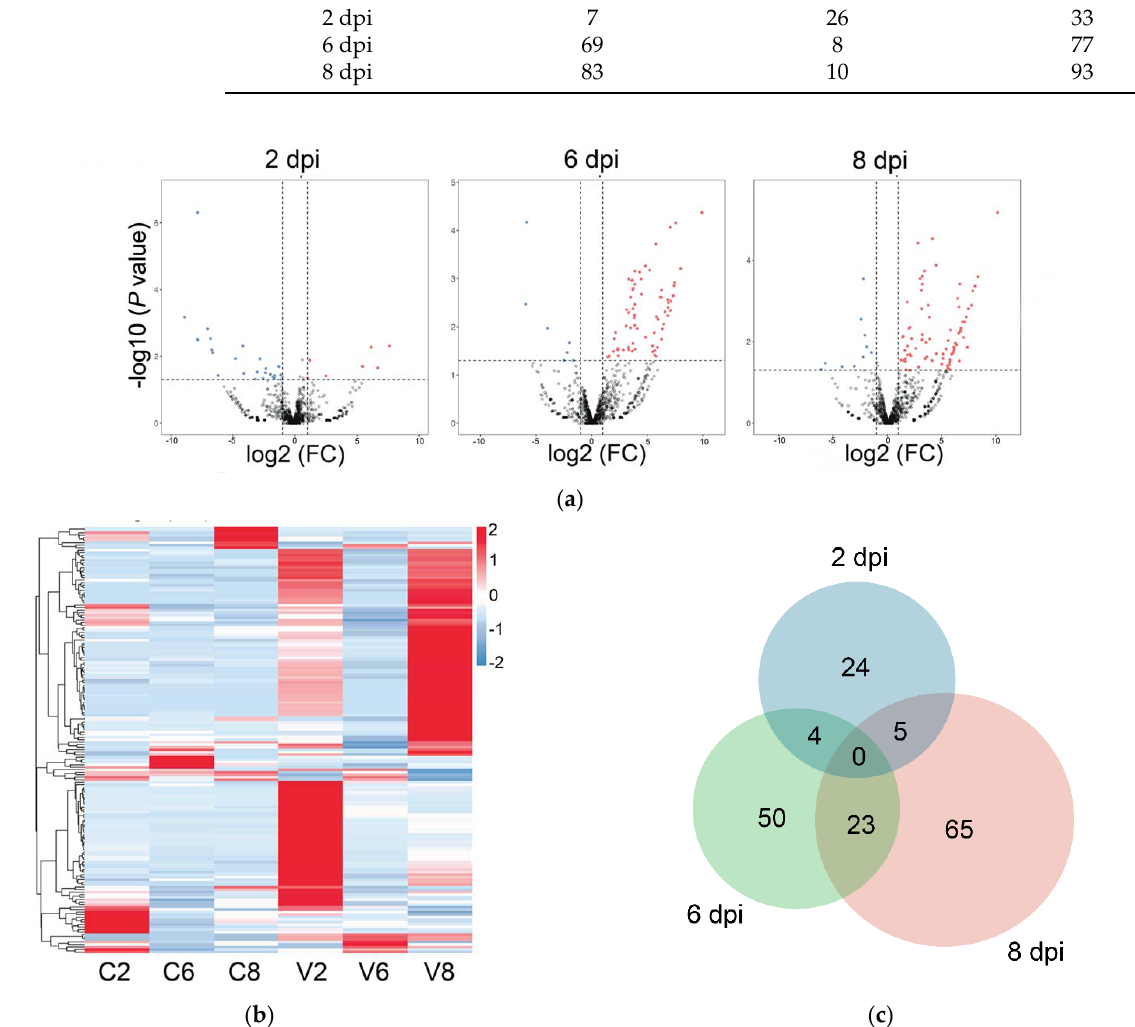
Figure 2. Analysis of differentially expressed miRNAs (DEmiRs) at different time points of infection. ( a ) Volcano plots of DEmiRs, at 2, 6, or 8 days post infection (dpi). The red and blue points represent up- and downregulated miRNAs, respectively; gray points represent miRNAs without significant change. FC, fold change; ( b ) The heatmap of DEmiR expression profiles in different groups at different time points. For convenience, “C2”, “C6”, and “C8” indicate the control groups at 2, 6, and 8 dpi, respectively; “V2”, “V6”, and “V8” indicate megalocytivirus-infected groups at 2, 6, and 8 dpi, respectively. ( c ) Venn diagram showing the overlap of DEmiRs at 2 dpi (blue), 6 dpi (green), and 8 dpi